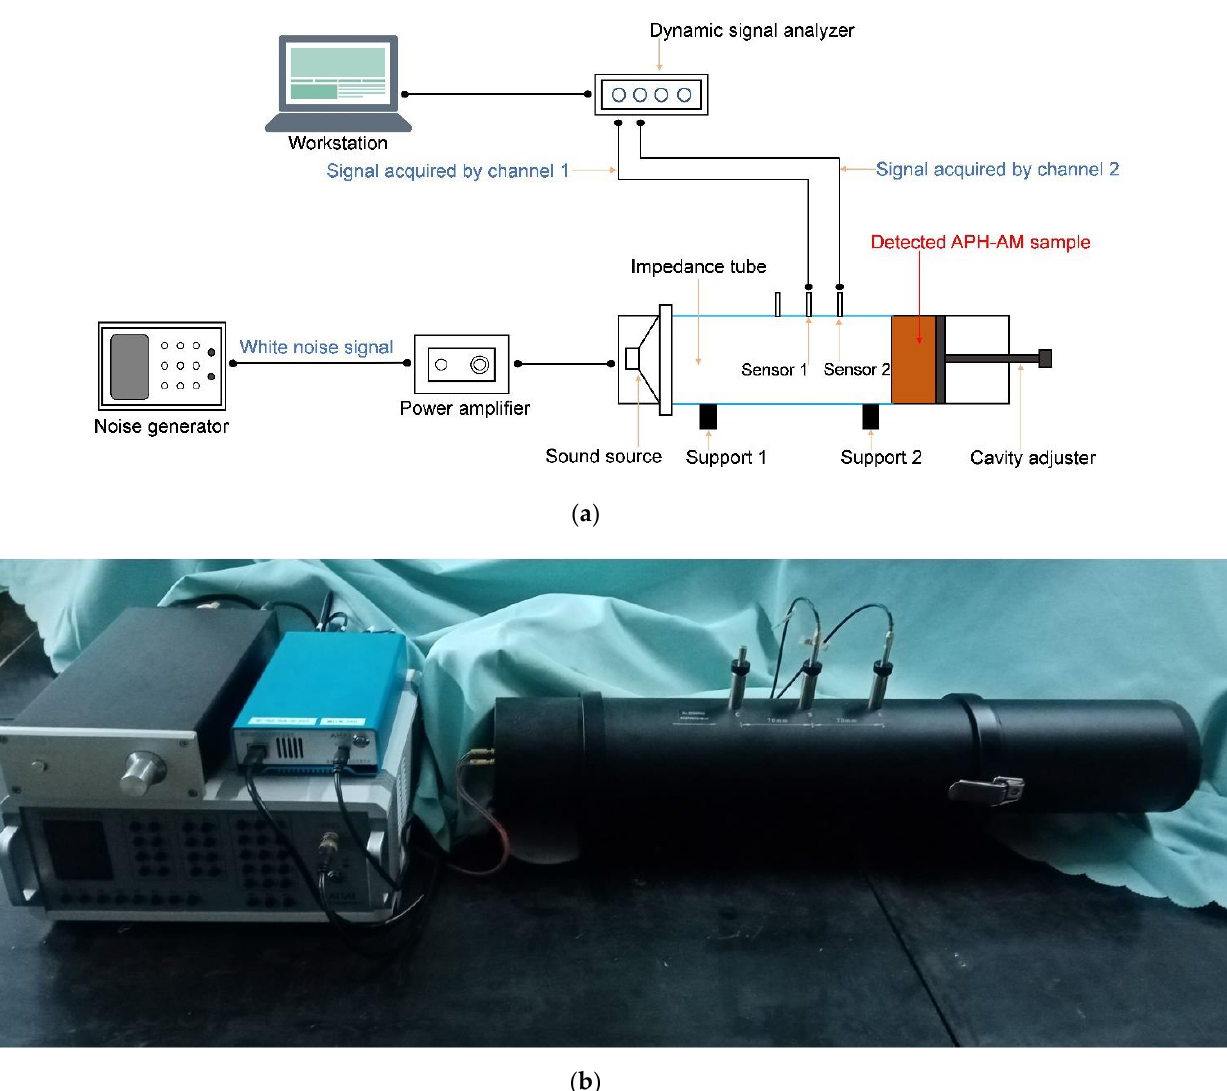
Figure 9. The transfer function tube measurement with detector of AWA6290T. ( a ) A schematic diagram; ( b ) an actual